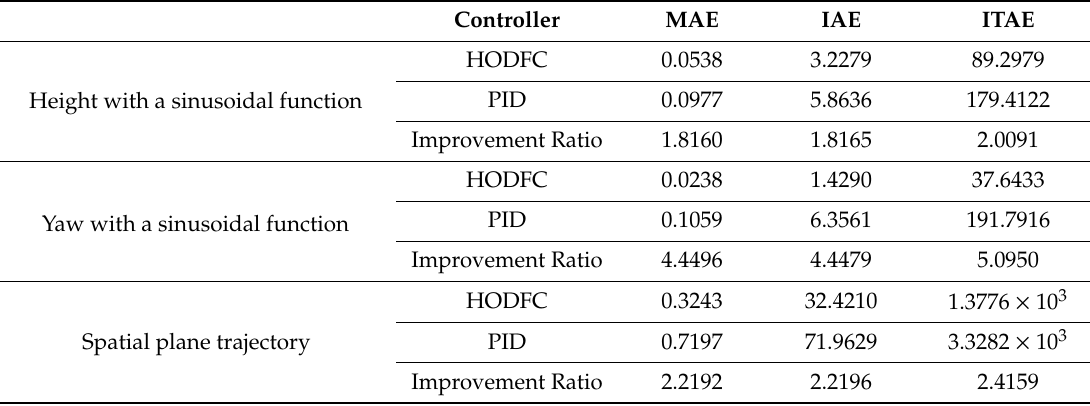
Height with a sinusoidal